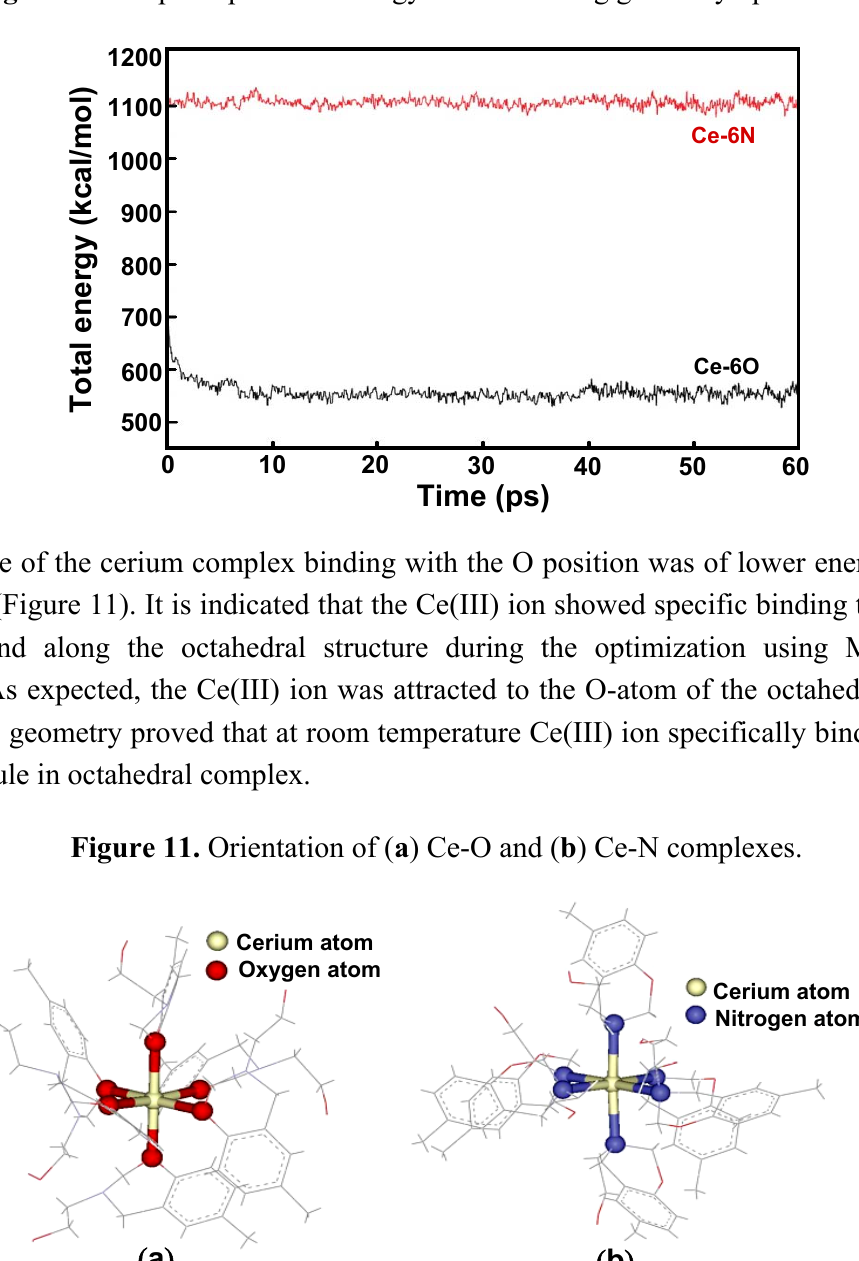
Figure 10. Graph of potential energy vs. time during geometry optimization.